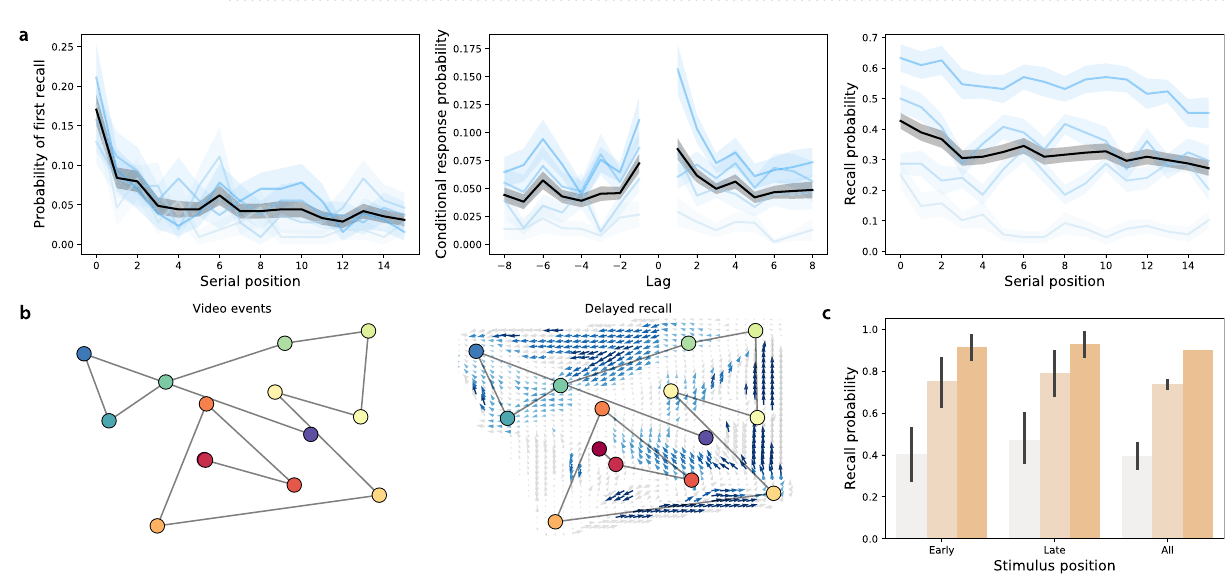
Figure 3. Delayed memory tests. ( a ) Free recall. These panels are in the same format as Fig. 2a, but they reflect performance on the delayed free recall task. For additional details see Fig. S2. ( b ) Naturalistic recall. These panels are in the same format as Fig. 2b, but the right panel reflects performance on the delayed naturalistic recall task. For additional details see Fig. S3. ( c ) Foreign language flashcards. This panel is in the same format as Fig. 2c, but it reflects performance on the delayed flashcards test. For additional details see Fig.